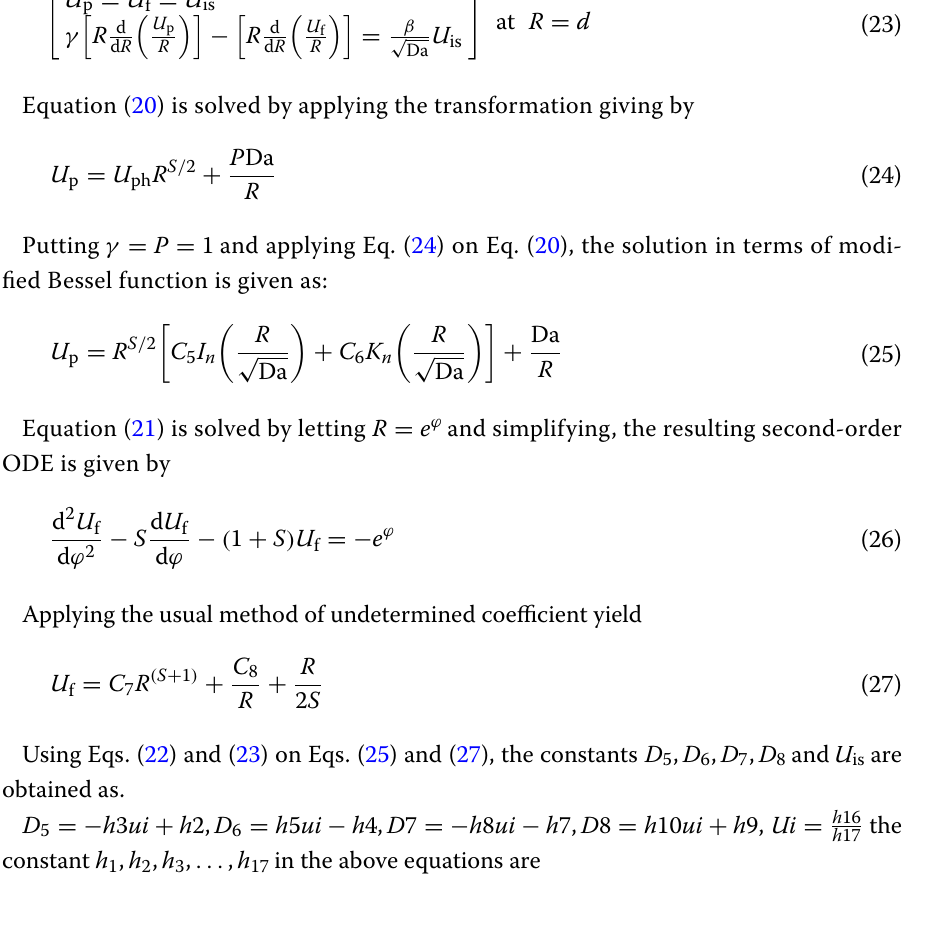
Table 1 Numerical values of both the steady and the transient state velocity obtained using the RSA, IFD, and the exact solution ( d R